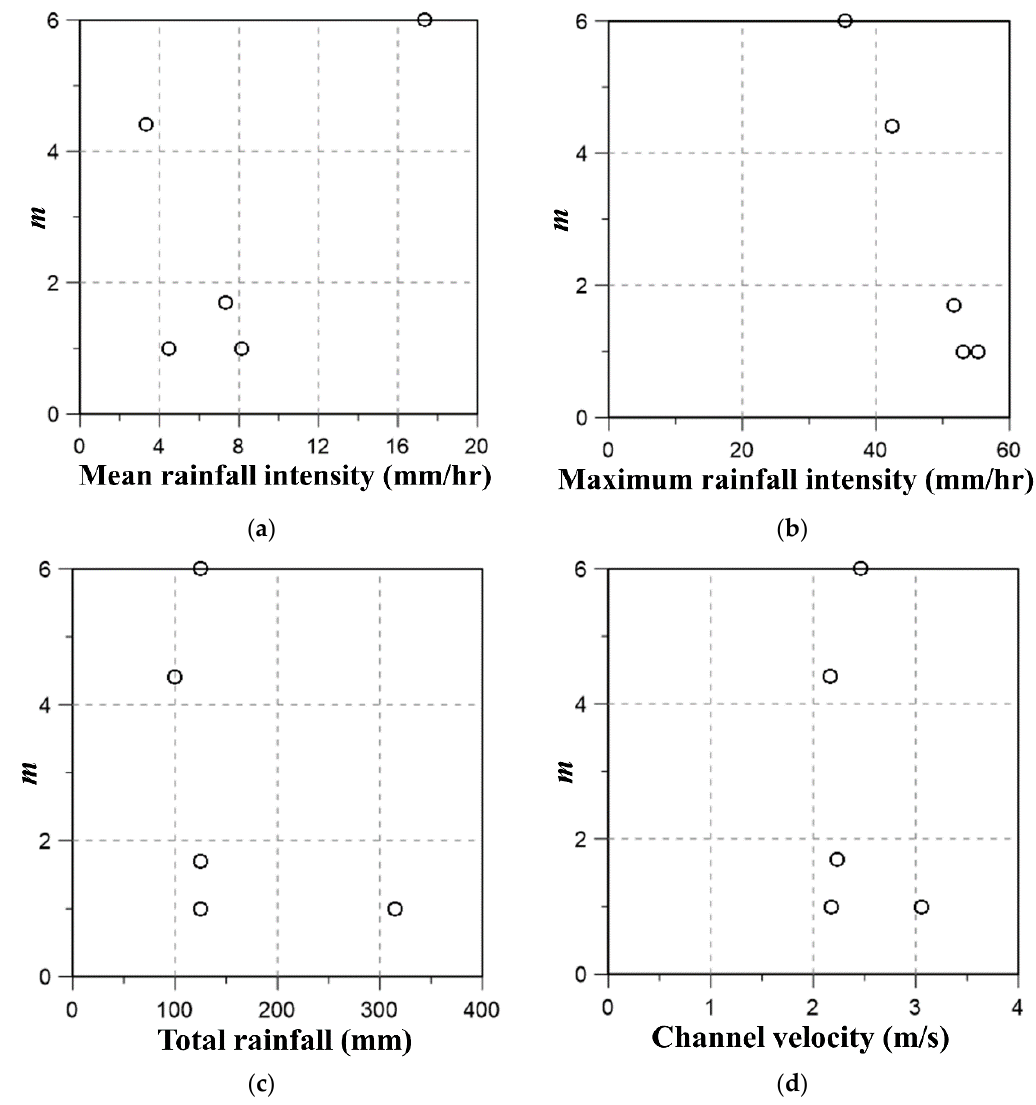
Figure 7. Change of the ratio ( m ) between the channel and the hillslope velocity with respect to ( a ) mean rainfall intensity, ( b ) maximum rainfall intensity, ( c ) total rainfall, and ( d ) channel velocity.